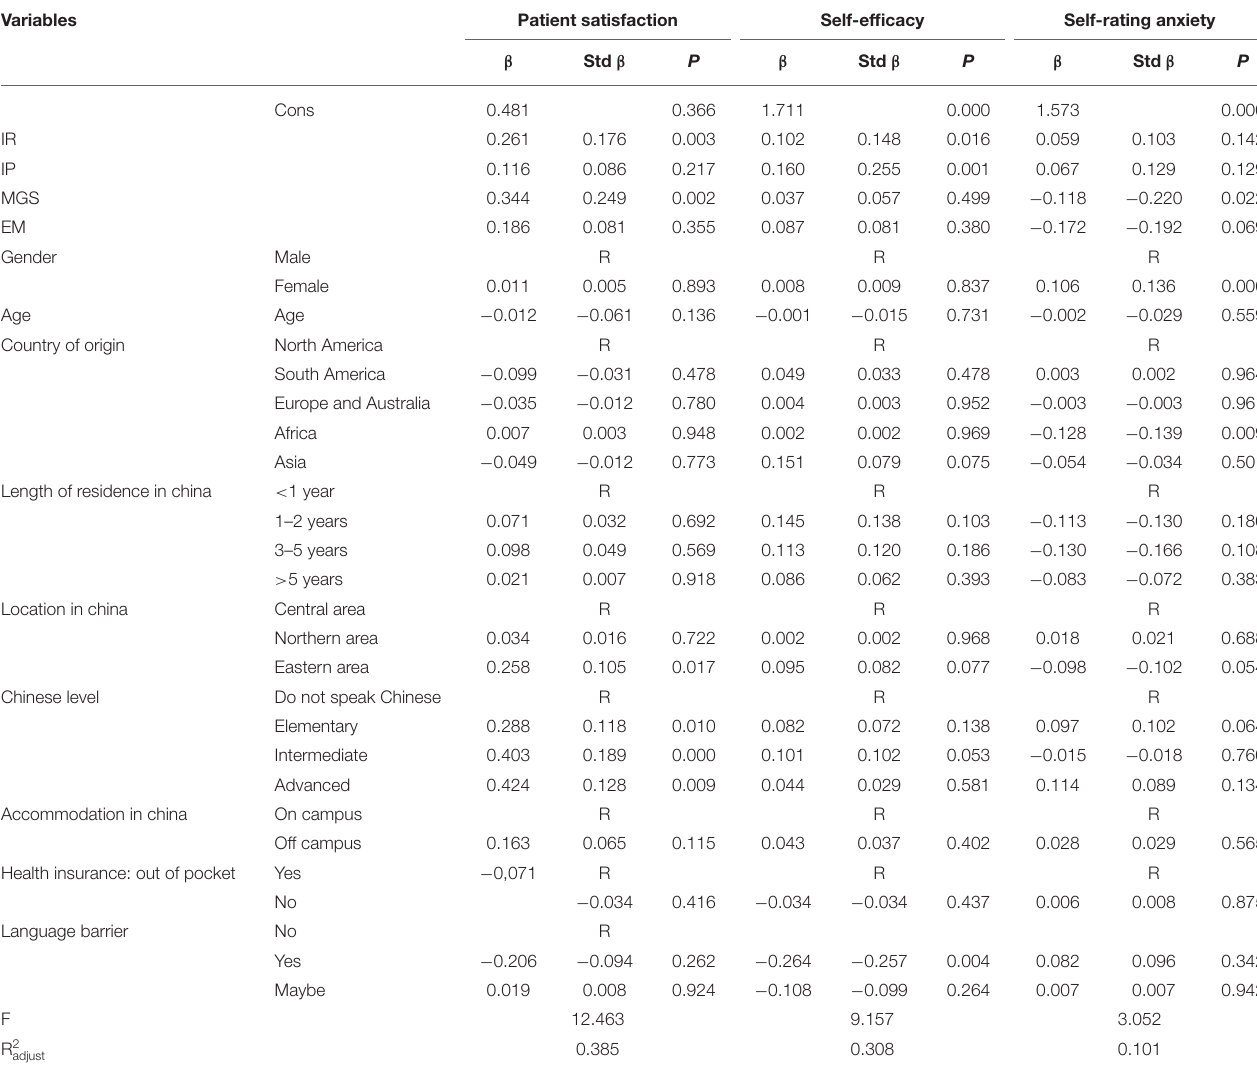
TABLE 3 | Regression analysis of the influence of transaction process on patient satisfaction, Self-rating anxiety and self-efficacy.